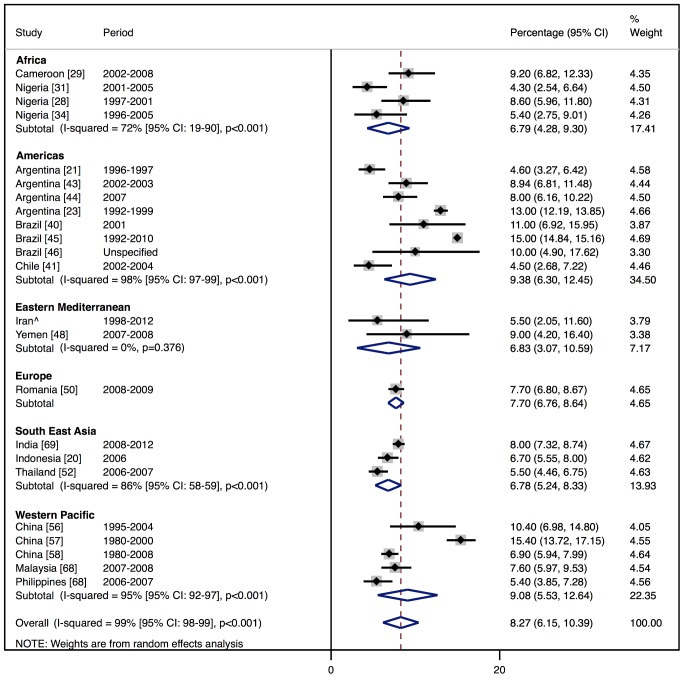
In-hospital mortality rates by region.∧Rahimzadeh S, Farzadfar F, Ghaziani M (2013) Iranian hospital data project (unpublished data).